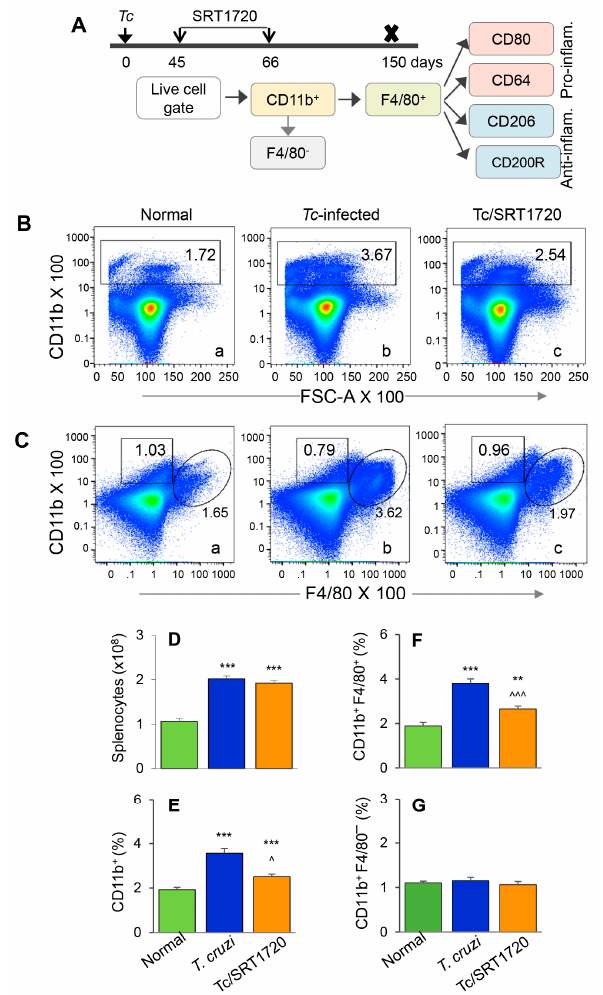
Figure 2. Splenic expansion of yolk sac Mo / M ϕ in Chagas mice in presence or absence of SRT1720. Figure 2. S plenic expansion of yolk sac Mo/M φ in Chagas mice in presence or absence of SRT1720. ( A ) Diagram shows the scheme of experimental plan. Briefly, C57BL/6 mice were infected with T. cruzi . After control of acute parasitemic phase by immune system, mice were treated with SRT1720 (SIRT1 agonist) for three weeks, and then euthanized at 150 days post-infection. Single cell suspensions of splenic cells were stained with fluorescence-conjugated antibodies. Flow cytometry